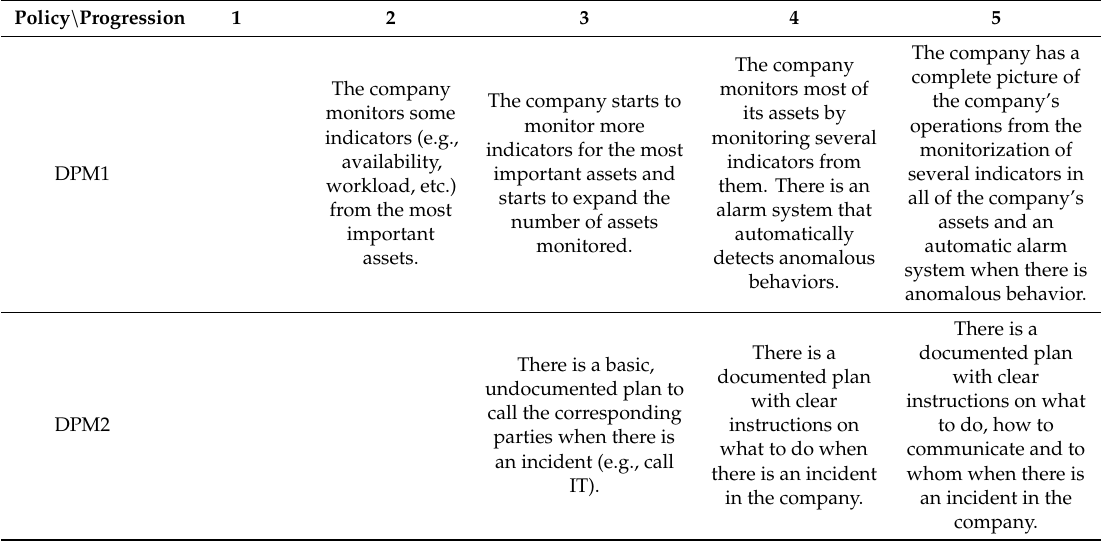
Table 25. Detection processes and continuous monitoring policies’ progression model.